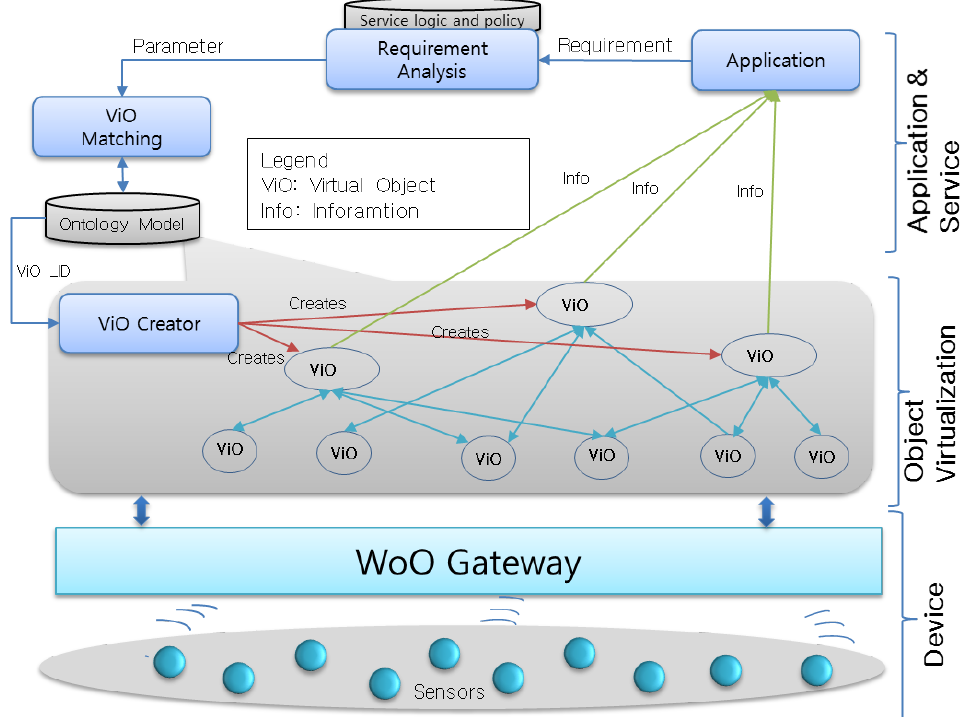
Figure 5. User requirements are analyzed and complied with the system policy. The next step is performed to find and select the required objects to form new ViOs to satisfy the user application requirements. The ontology model defines the relationships among